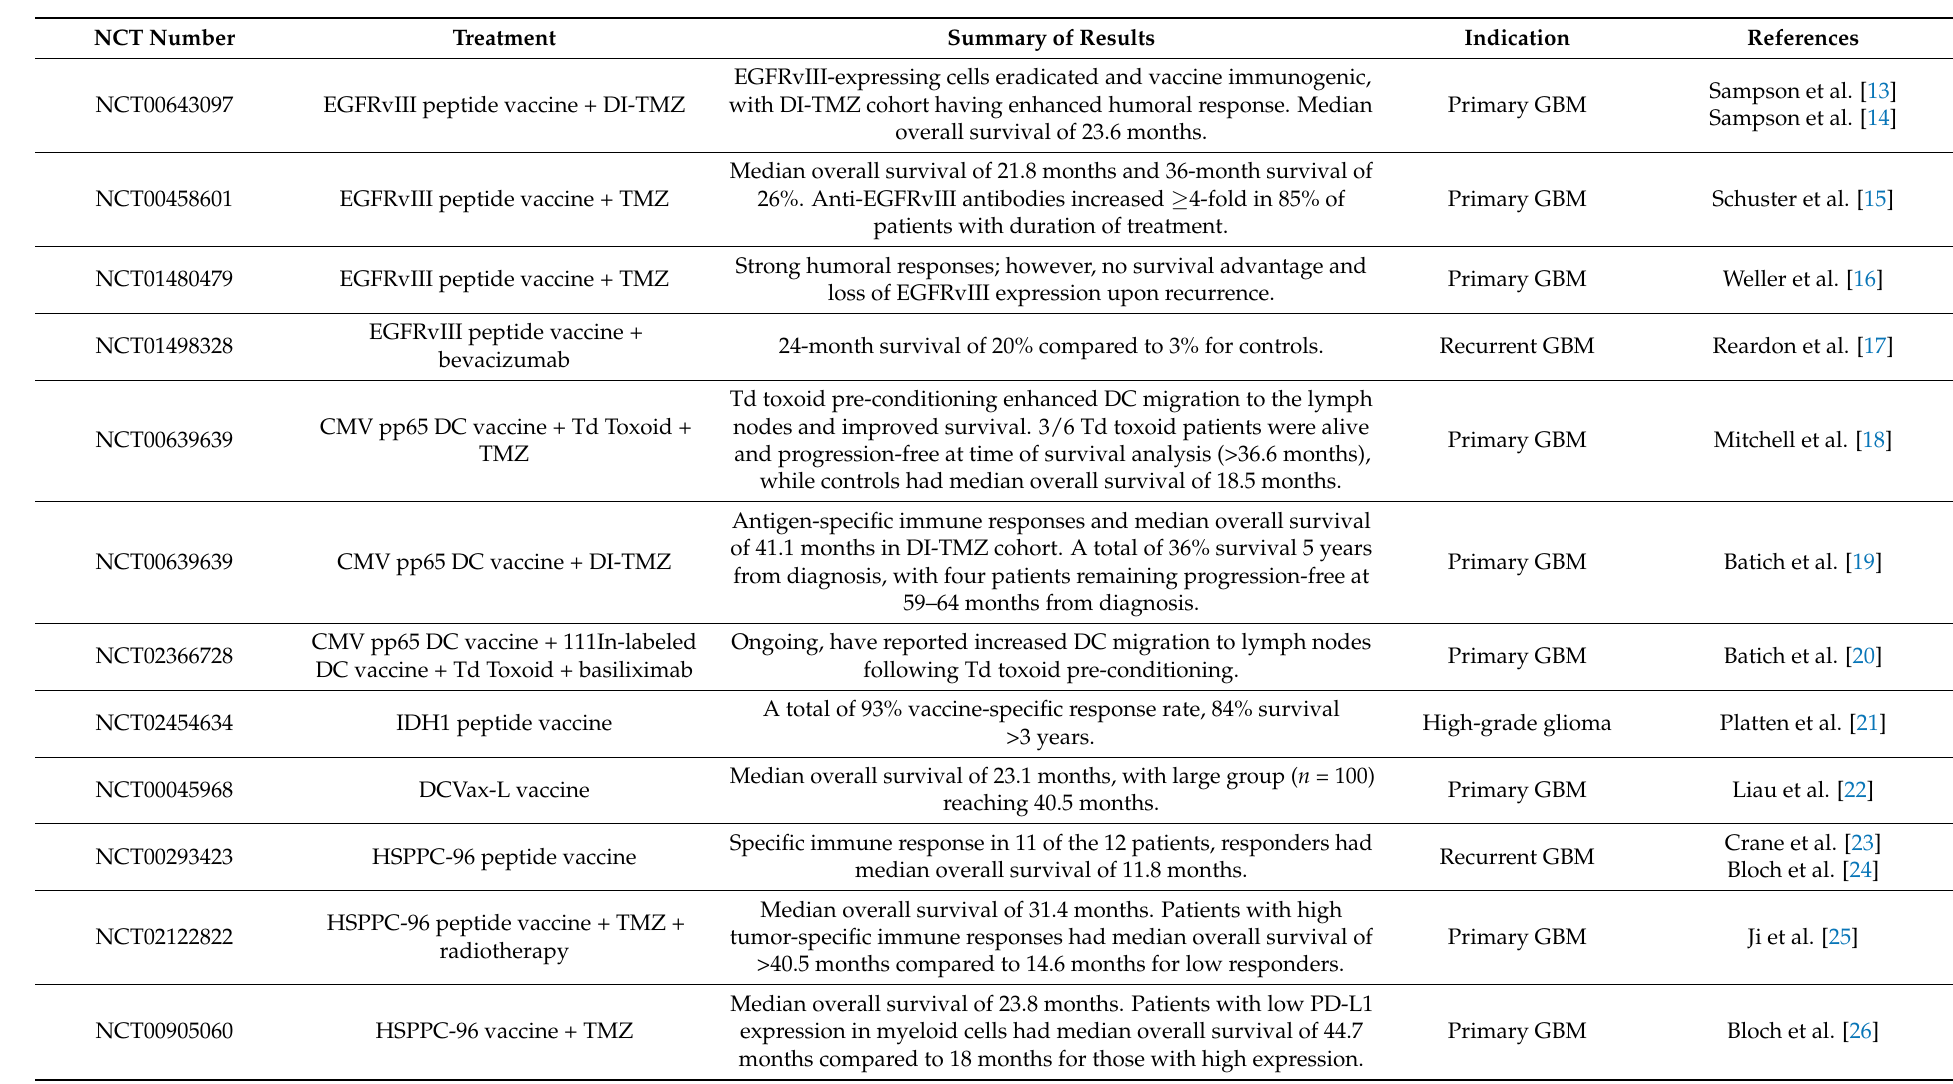
Table 1. Summary of clinical trials for vaccines against